Question: What kind of plot is shown here?
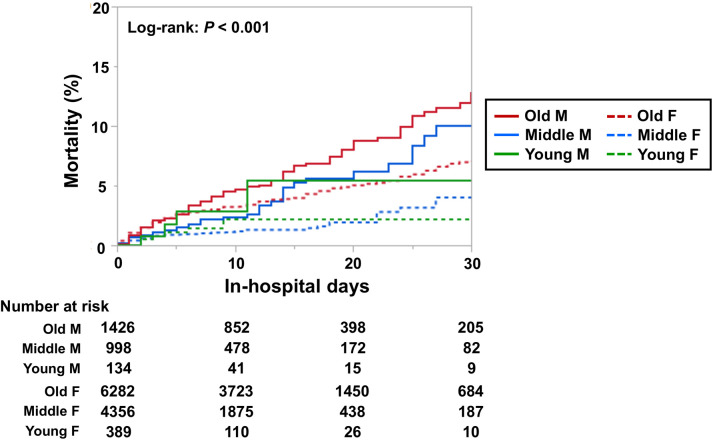
Answer: survival